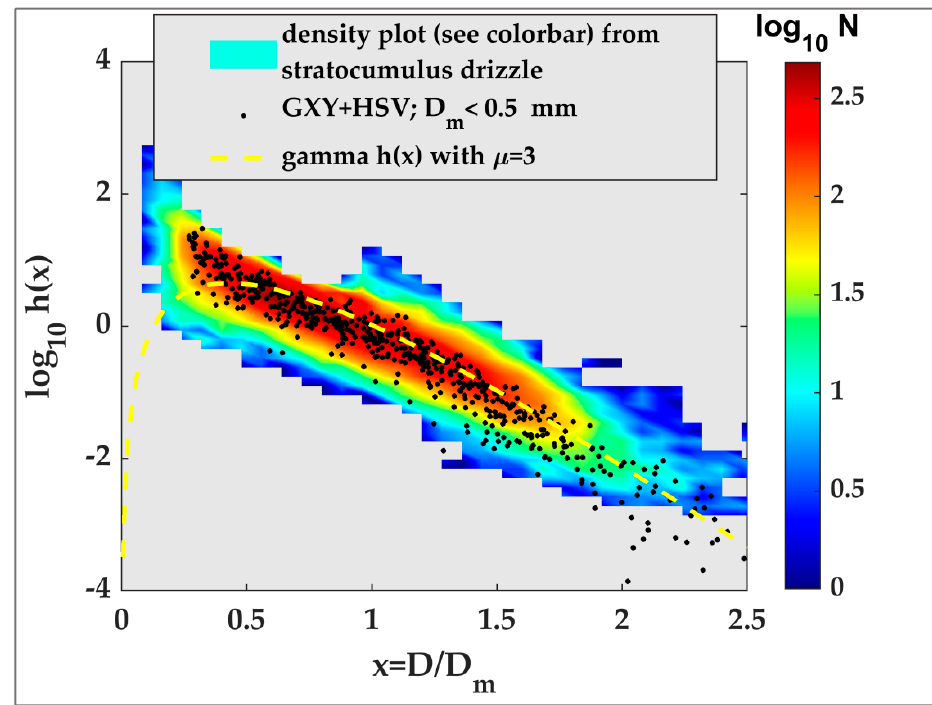
Figure 2. Density plot of h(x) from stratocumulus drizzle with number of occurrences given by the color bar in contours of log N. The GXY-HSV data are pooled together for D m < 0.5 mm and shown as black points. The dashed yellow line is the h(x) for the gamma model with μ = 3. The colored contours of the density of h(x) for the drizzle are compact and the scat-